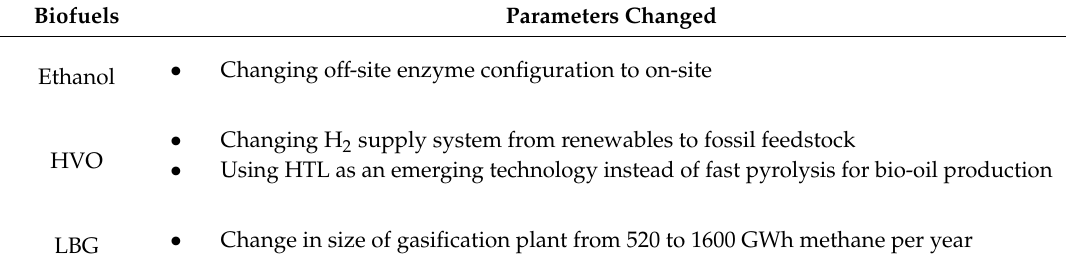
Table 3. Sensitivity analysis parameters used in the study for various